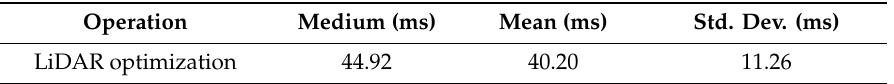
Table 11. Average optimization time per keyframe in LiDAR correction